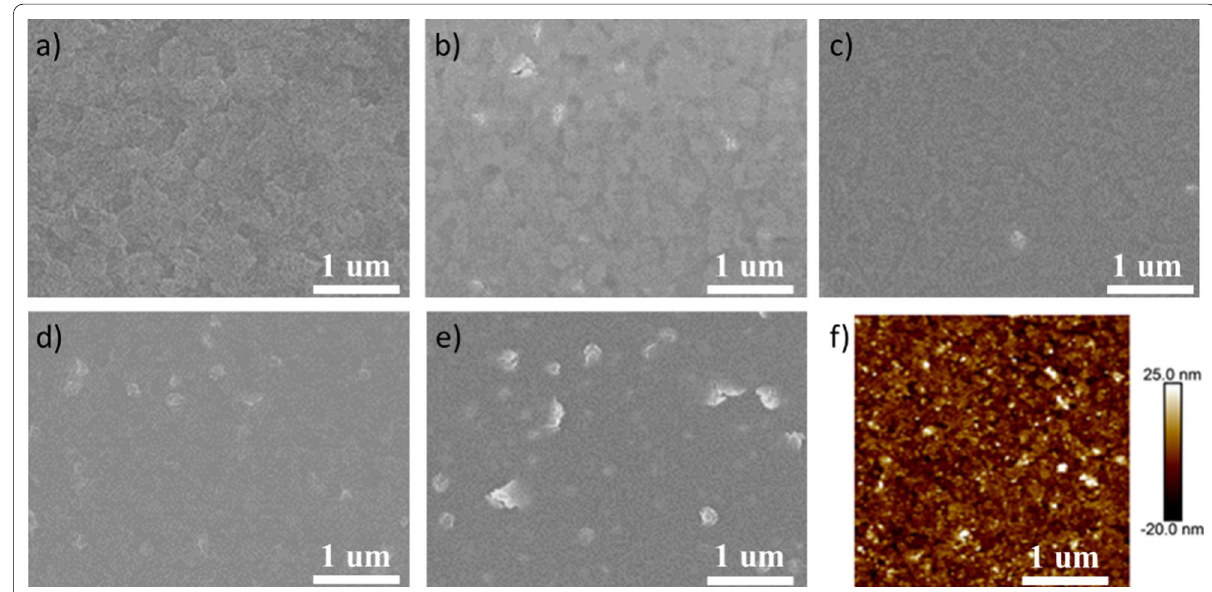
Fig. 3 Morphology characterization of Ni 3 (HITP) 2 films with different thicknesses. SEM images of a Bare ITO-coated glass and b – e Ni 3 (HITP) 2 films with 20 nm, 30 nm, 40 nm, 50 nm, respectively; f AFM image of Ni 3 (HITP) 2 film of 30 nm thickness